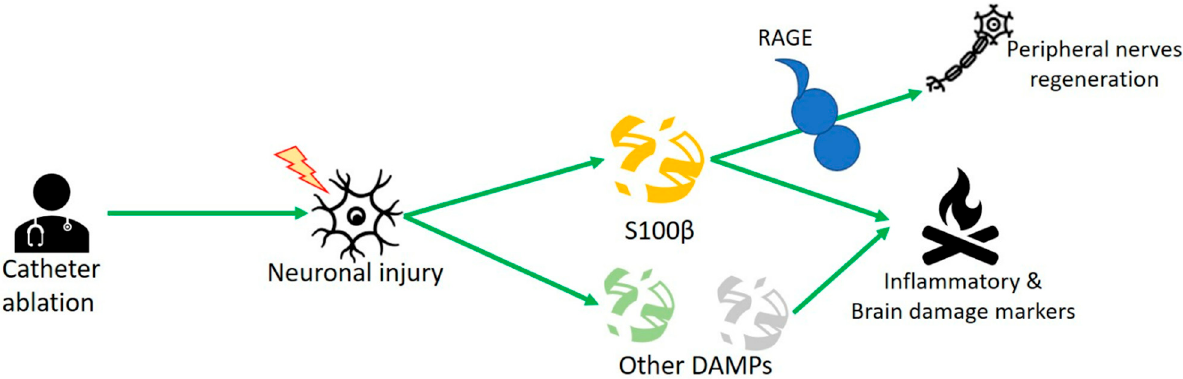
Figure 2. S100 β is released because of the neuronal injury of the intrinsic cardiac autonomic nervous system (ICSN), which releases other damage-associated molecular pattern proteins (DAMPs). At the same time, the trophic role of S100 β is also shown, which, released from glial cells, through the RAGE receptor would be able to regenerate peripheral cardiac nerves.